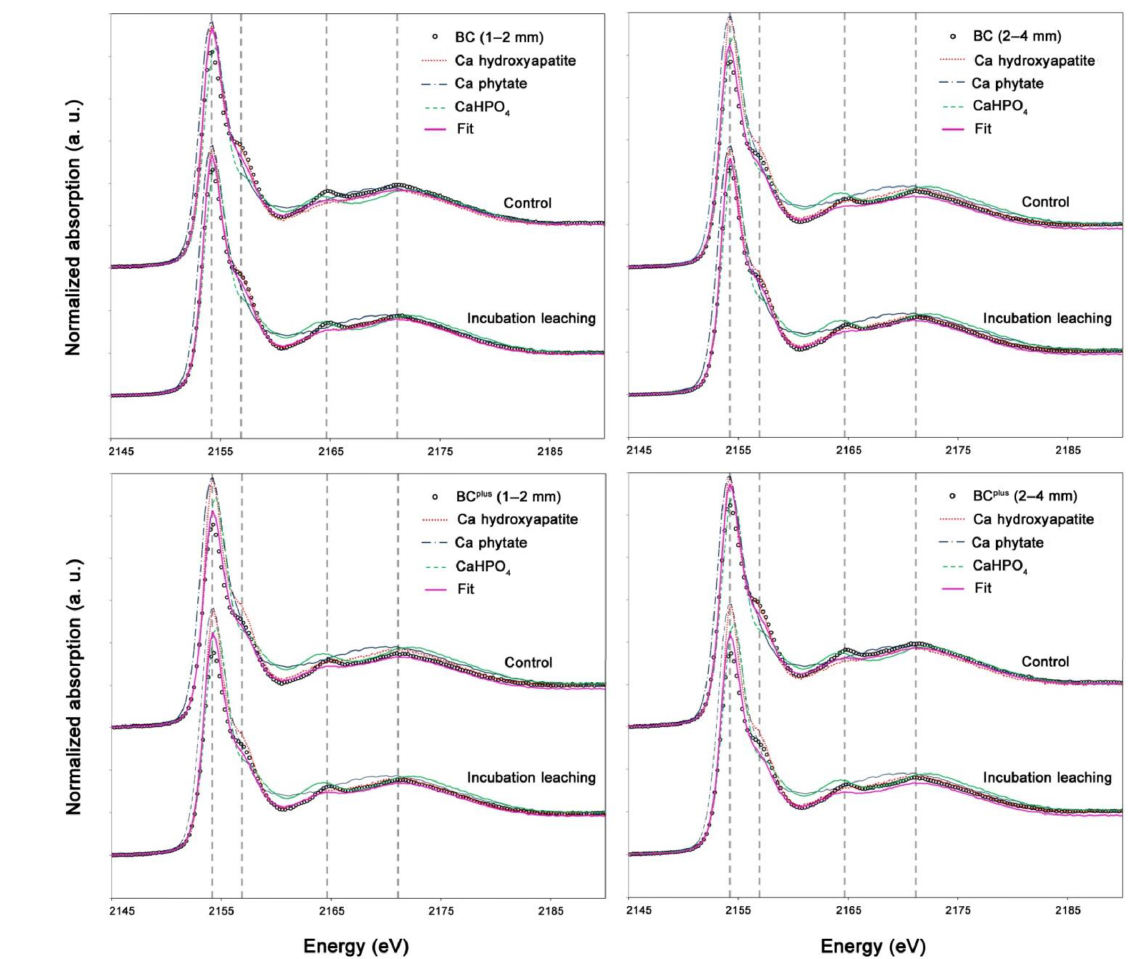
Figure 1. Normalized P K -edge XANES spectra of different BC and BC plus particle sizes (1–2 and 2–4mm) before (control) and after a 70-day incubation-leaching experiment compared to the reference compounds selected using the LCF method.